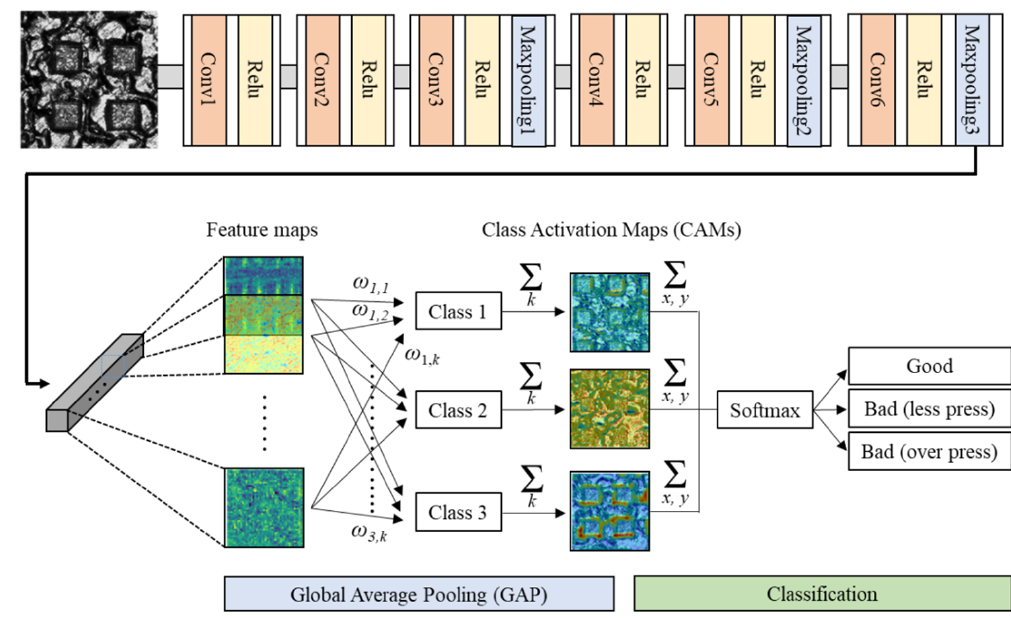
Figure 4. Structure of CNN with CAM.